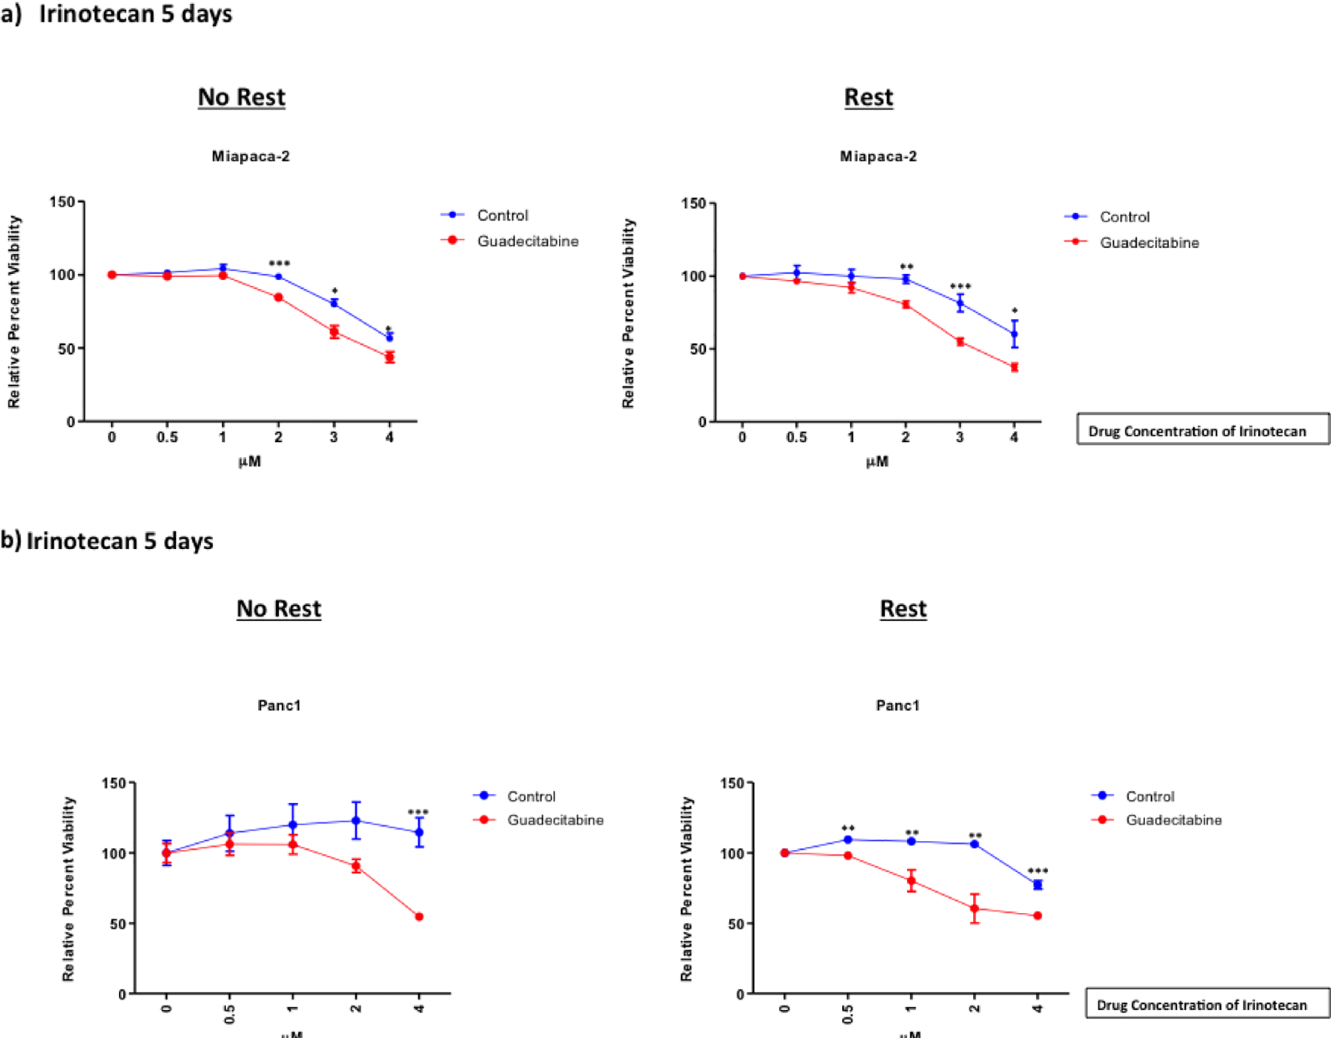
Fig 3. Guadecitabine sensitized PDAC cells to chemotherapy. Miapaca-2 (a) and Panc1 (b) were treated with 0.14x10 -3 μ M for 3 days. Cells were treated with varying concentrations of Irinotecan either immediately or after 5 days of rest. Cells were incubated in Irinotecan for an additional 5 days. Viability was measured using a standard MTT assay. Each data point was compared to the control respectively, and represented as percent cell viability. Statistical analysis was performed using a non- parametric t test. Data shown represents mean ± SEM.